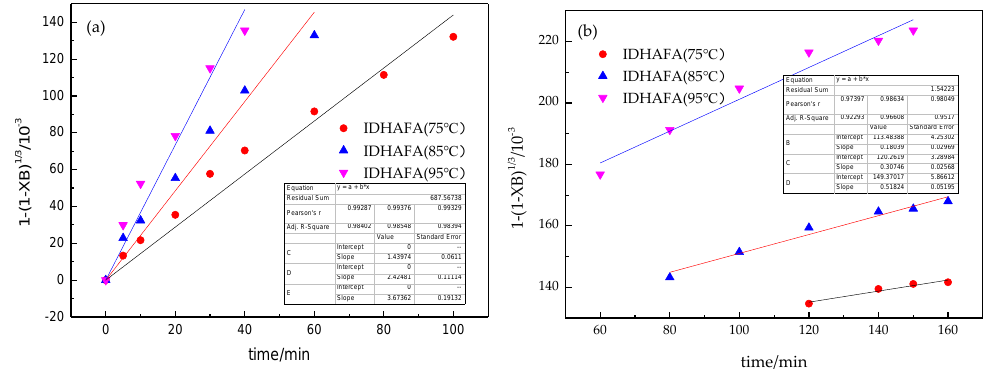
Figure 7. Mathematical fitting of data of SiO 2 leaching kinetics in enhanced desilication process: ( a ) The earlier stage, ( b ) The later stage.